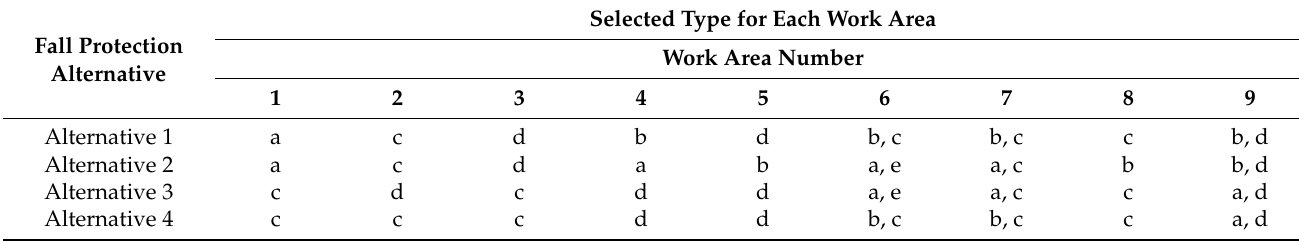
Table 4. Selected types for construction work areas in each fall protection